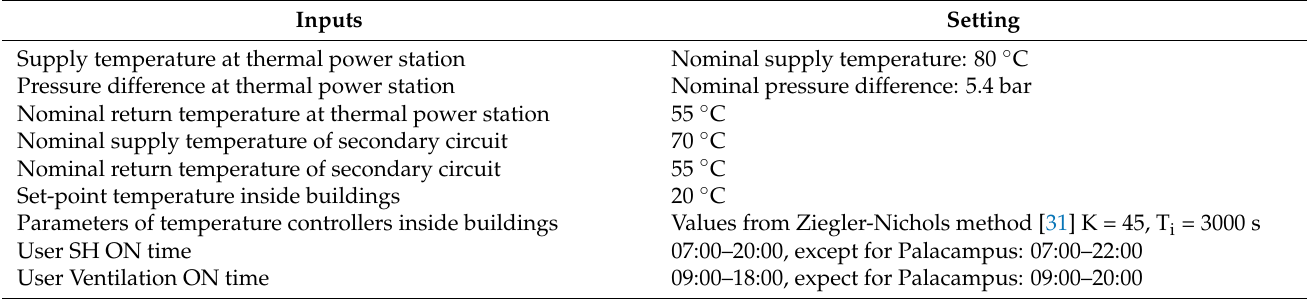
Table 3. Inputs of the Reference Case (Scenario 1) of dynamic simulation.